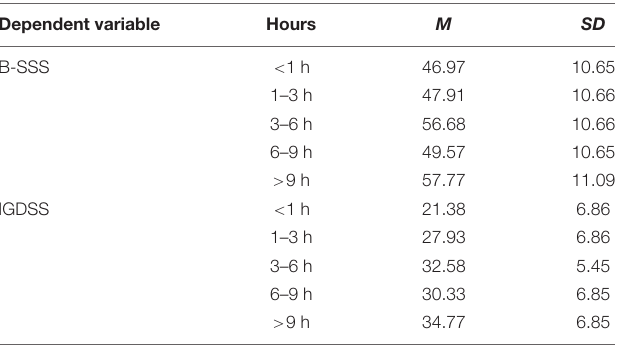
TABLE 8 | Post hoc analysis of univariate analysis of variance (ANOVA) for internet gaming disorder short scale (IGDSS). Dependent